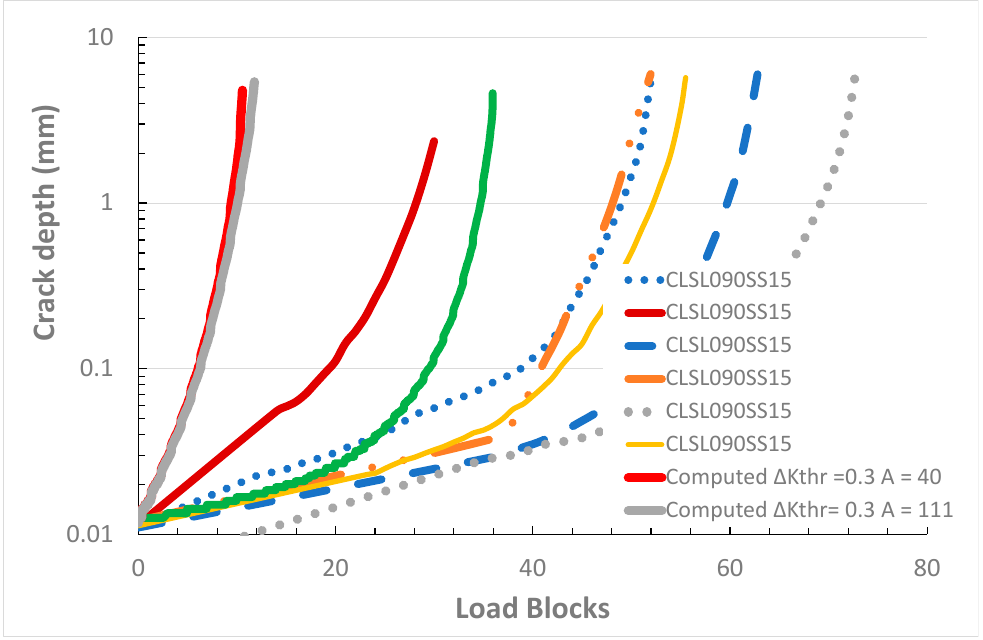
Figure 15. The effect of different toughness on the measured and computed curves for the helicopter flight load spectra CSL090SS15.